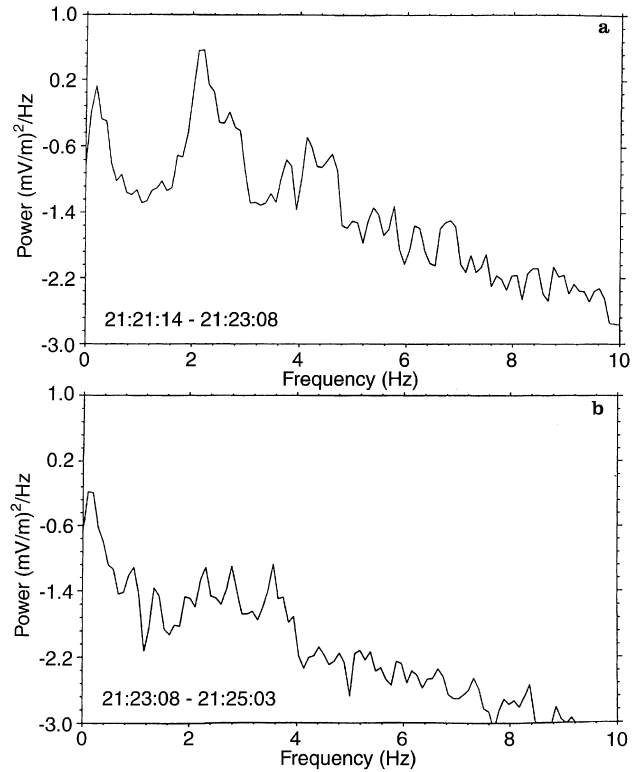
component at two di(cid:128)erent time- X and its harmonic are observed O